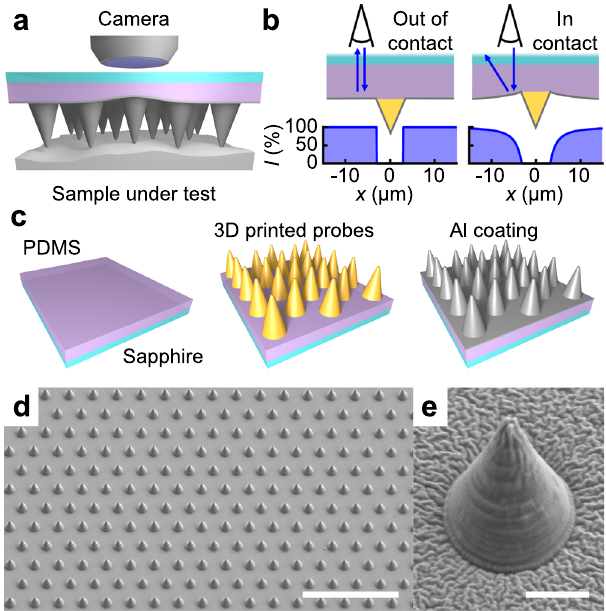
Fig. 1 Cantilever-free atomic force microscopy. a Scheme of the experimental setup as viewed from the side. Probe – sample contact results in deformation of the elastomer thin fi lm. b Illustration of the optical contrast upon deformation of the elastomeric thin fi lm as viewed through the sapphire wafer. The re fl ected light intensity I changed with position x . The optical signature of probe motion is termed a distributed optical lever.